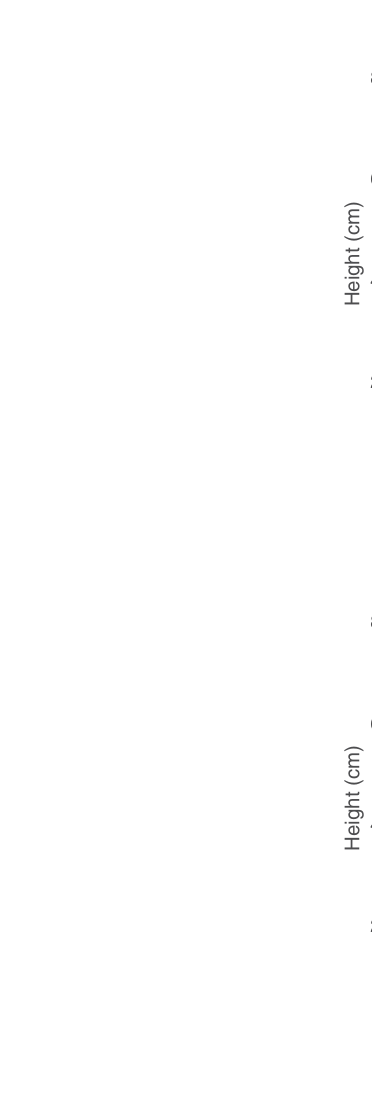
FIGURE 12 Comparing the CVP obtained from (A) the same directions of travel and (B) the perpendicular directions of travel from one container on